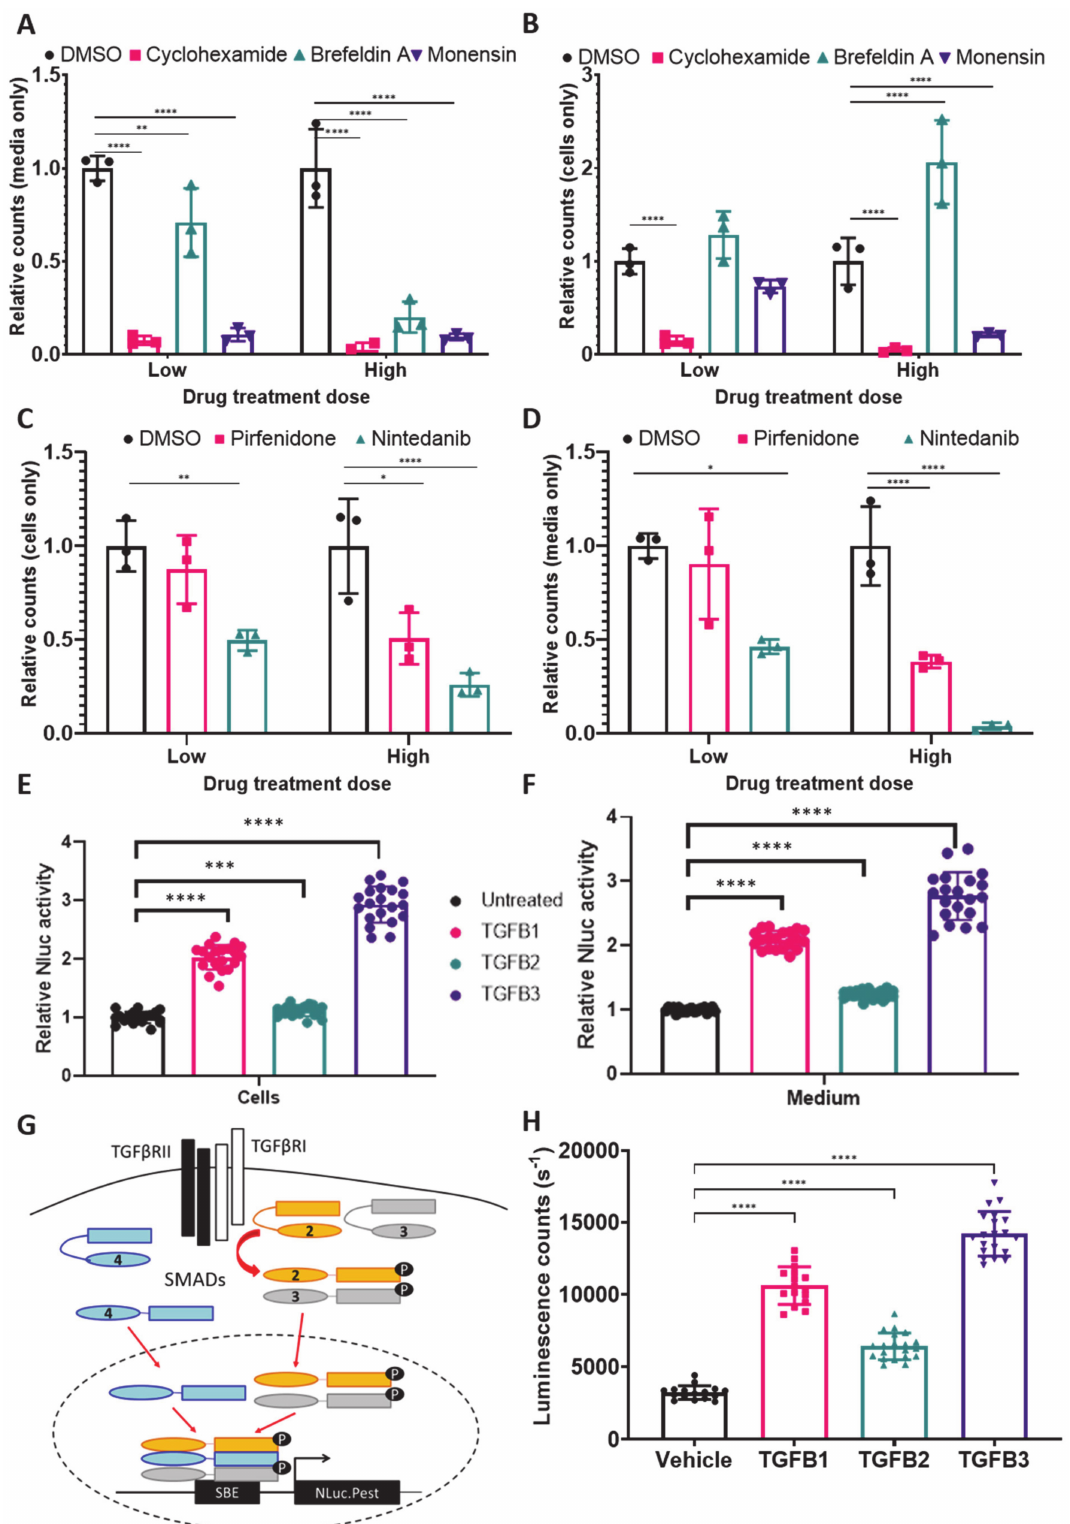
Figure 5. NLuc-PC-I response to known collagen modulators. ( A ) Cellular luminescence in nluc::Col1a2 cells treated with cycloheximide or the secretion inhibitors Brefeldin A and Monensin after 24 h; the doses used are shown in Table S3. Bars show the mean ± SD for n = 3 independent replicate measurements. ( B ) The levels of secreted NLuc after 24 h treatment are shown, demonstrating each treatment results in inhibition of NLuc-PC-I secretion. Bars show the mean ± SD for n = 3